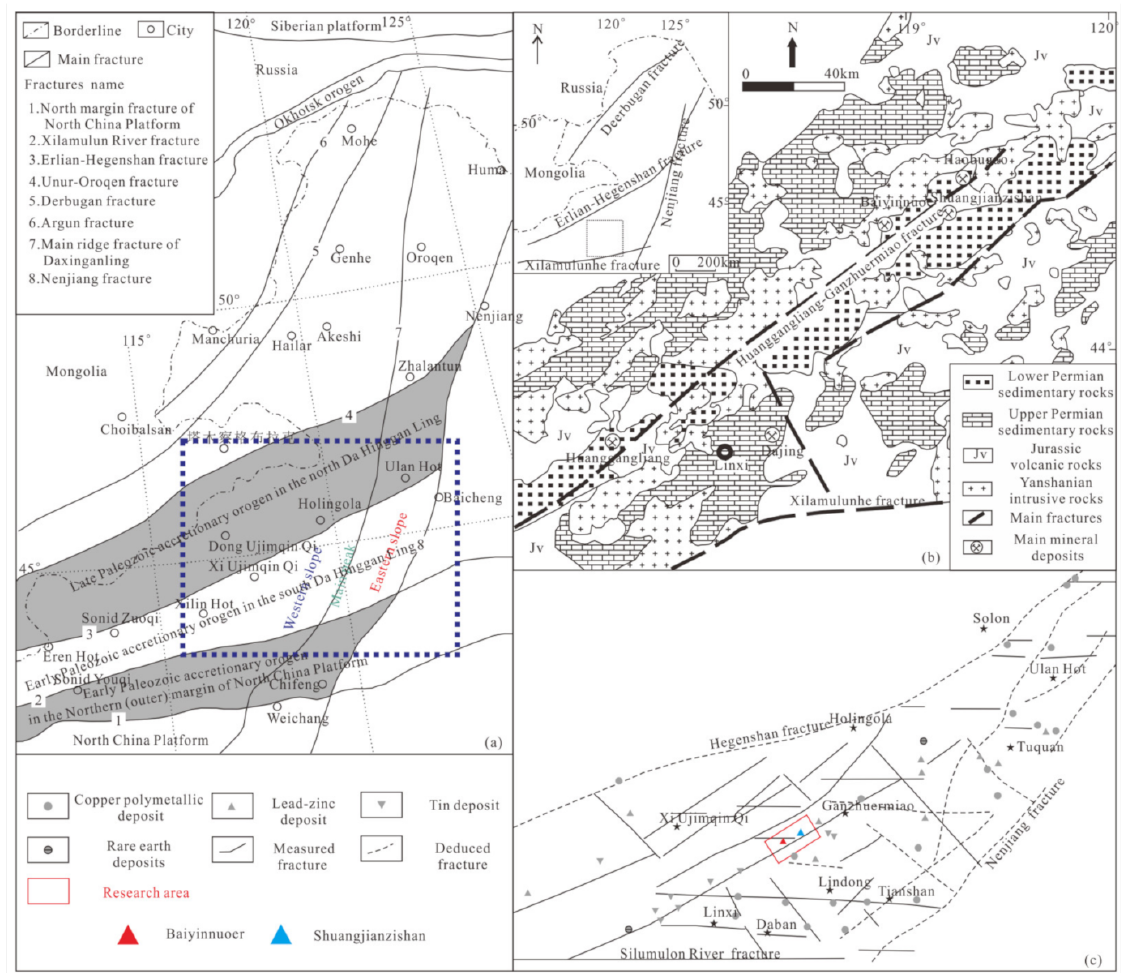
Figure 4. ( a ) Tectonic pattern in the southern part of Daxinganling; ( b ) Geological map; ( c ) Mineral